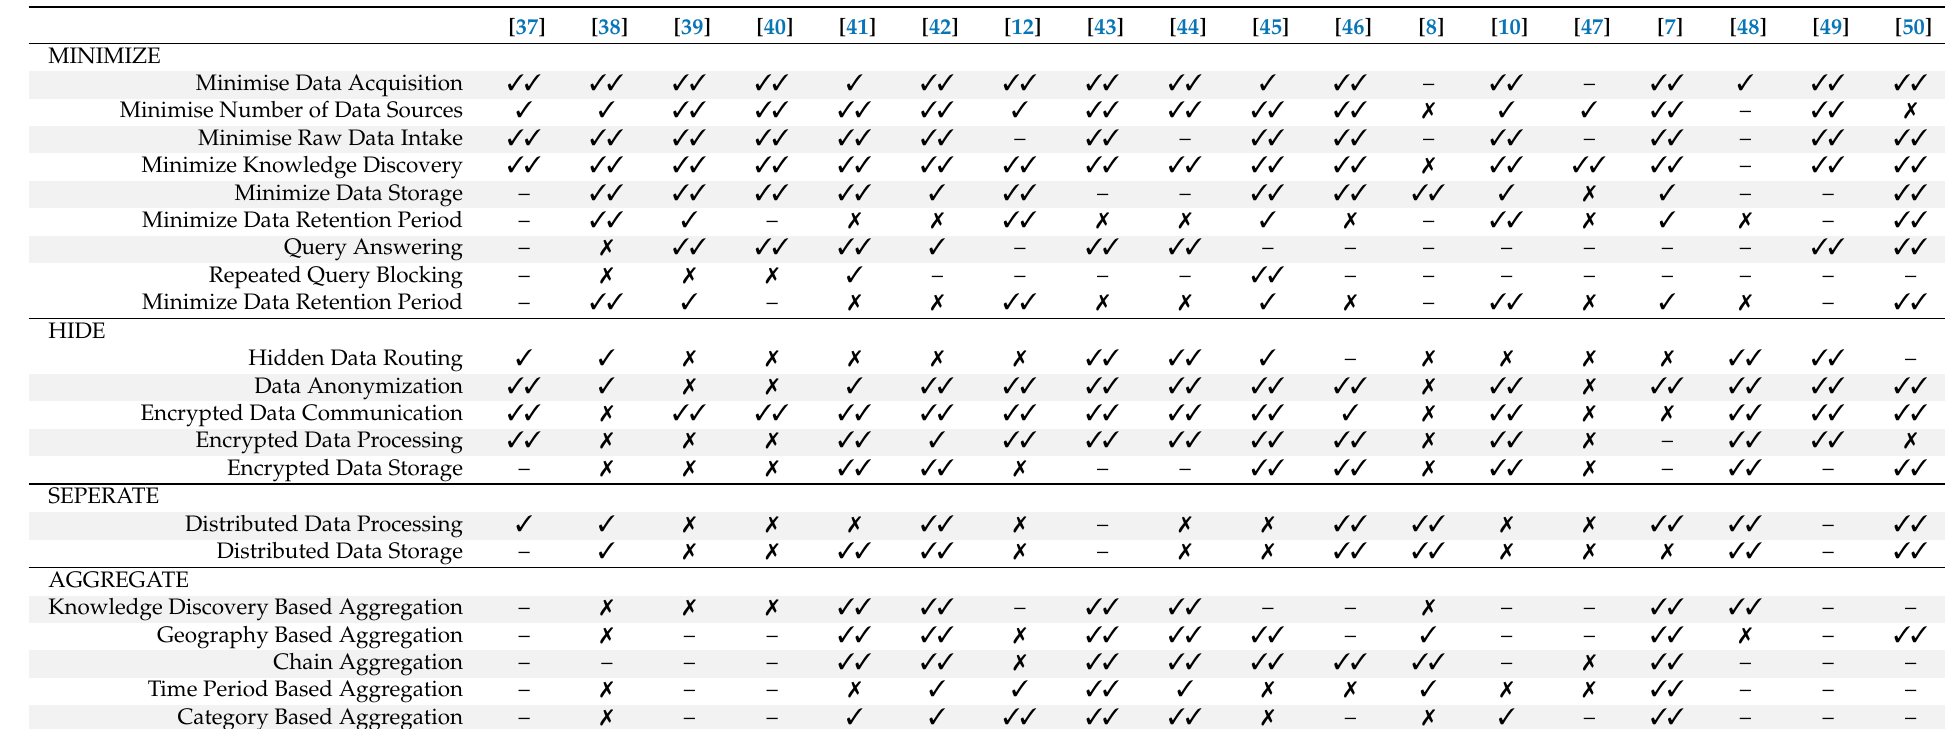
Table 5. Guidelines by Perera et al. [3] for data-oriented strategies applied to the selected articles.